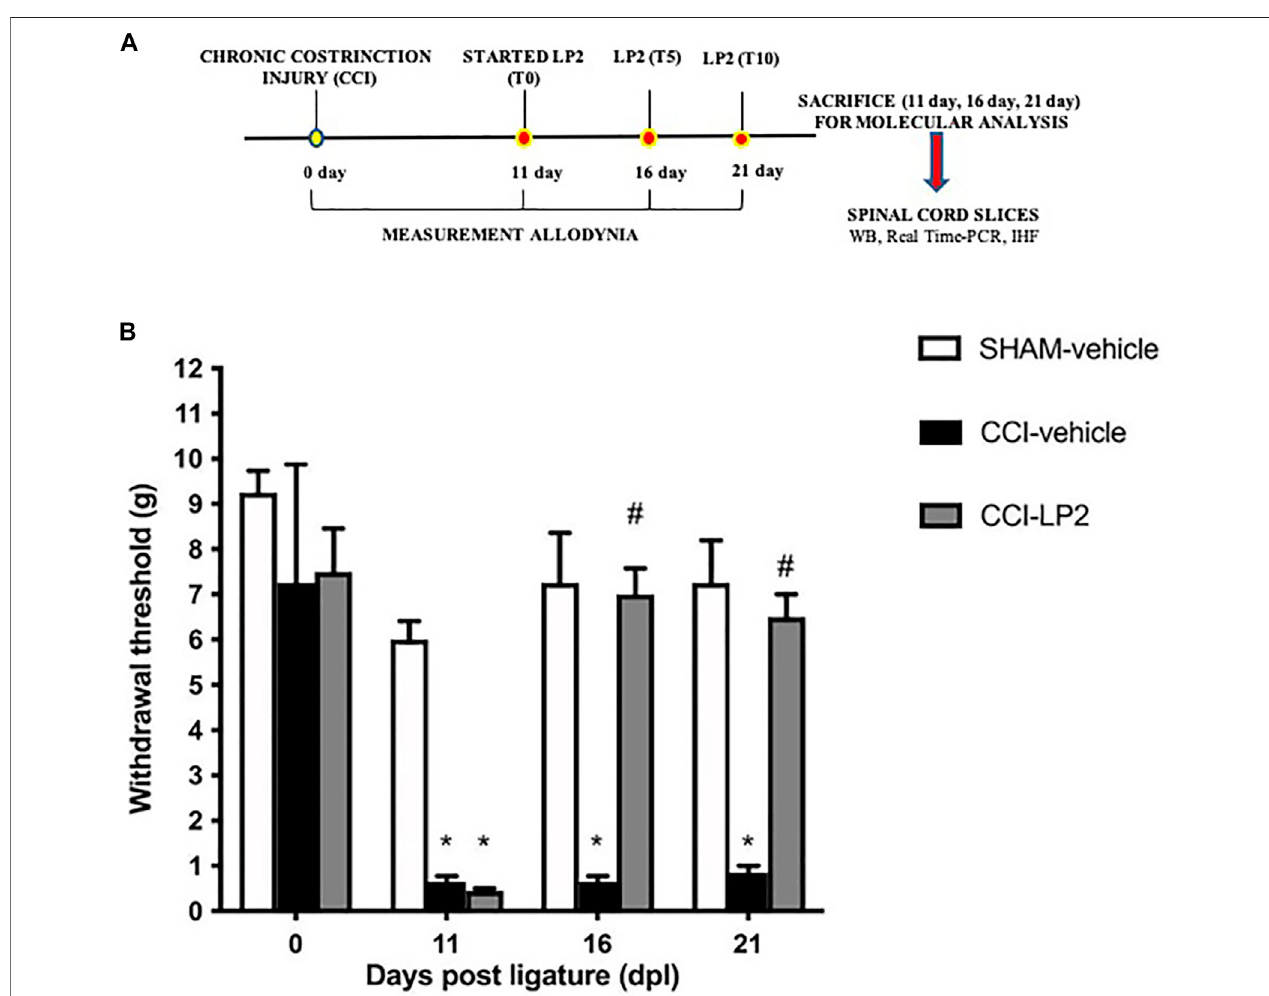
FIGURE 1 | The MOPr/DOPr agonist LP2 shows an anti-allodynic effect in CCI animal model. (A) Schematic representation of the experimental design. WB (cid:1) Western Blot; Real Time-PCR (cid:1) Real Time Polymerase Chain Reaction; IHF (cid:1) Immunohisto fl uorescence analysis. (B) Withdrawal thresholds measured with von Frey ’ s fi laments on SHAM-vehicle, on SHAM-vehicle, CCI-vehicle, and CCI + LP2-treated rats at 0, 11 (before the start of LP2 administration), 16, and 21 dpl. Data are shown as mean ± SEM of n (cid:1) 8 rats per group. * p < 0.001 vs SHAM-vehicle. # p < 0.001 vs. CCI-vehicle.